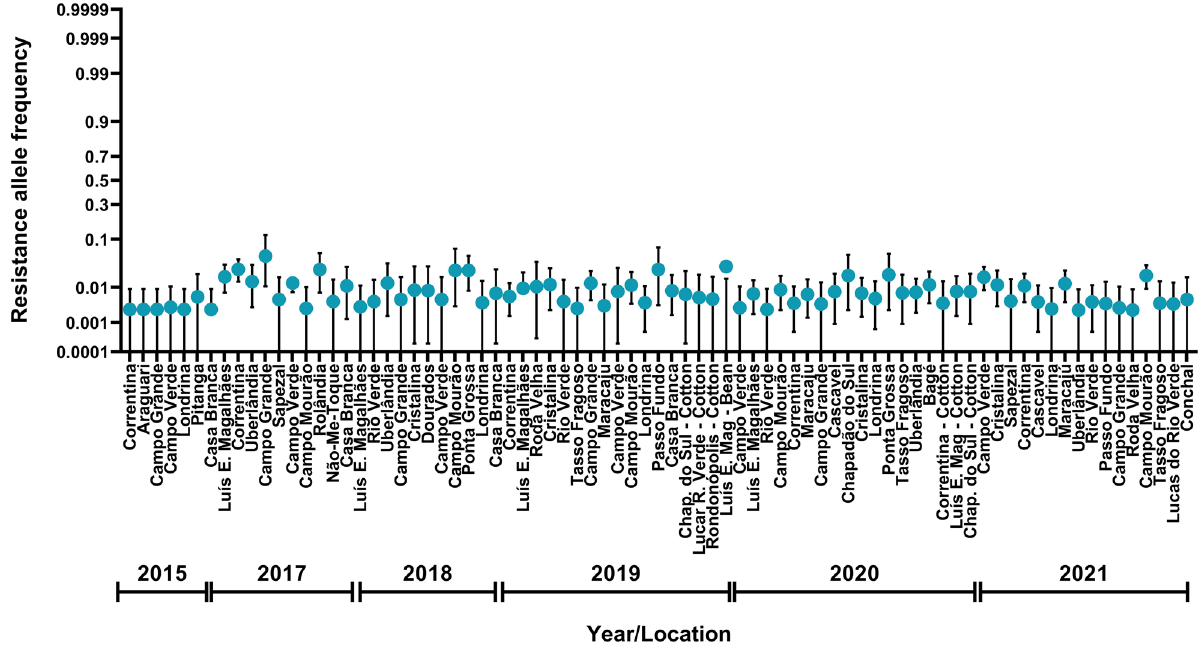
Figure 2. Frequency of resistance alleles conferring resistance of C. includens to MON 87701 × MON 89788 soybean in Brazil. Data from 2014/15 were previously reported by Yano et al. 10